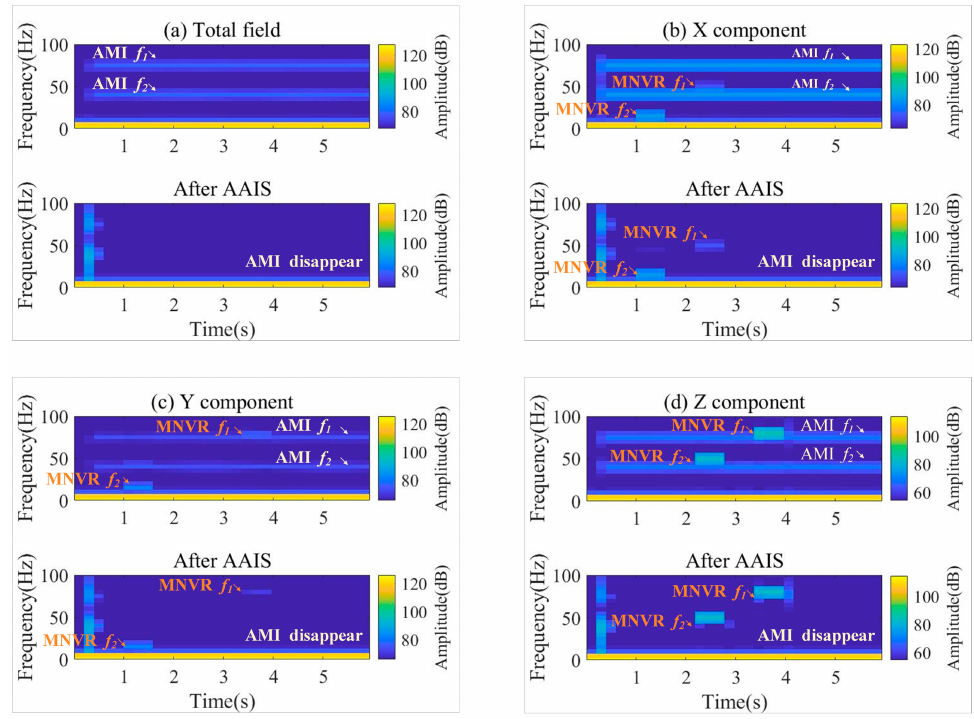
Figure 5. Time–frequency diagrams of the data before and after AAIS. ( a ) Total magnetic field; ( b ) X component; ( c ) Y component; ( d ) Z component. AMI is the abbreviation for alternating magnetic interference. MNVR is the abbreviation for maneuver. f means the frequency.